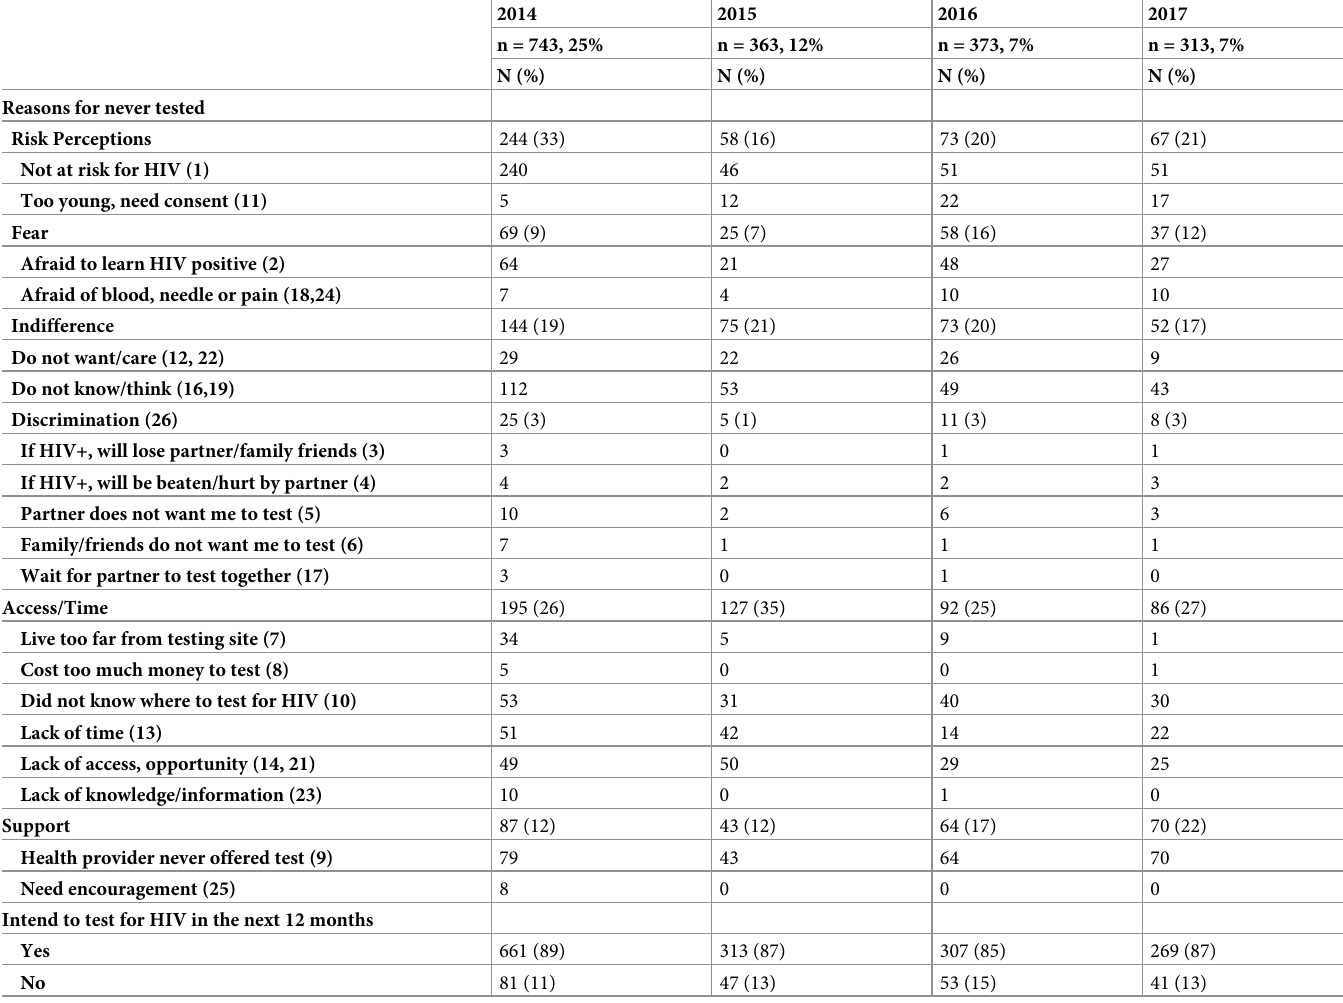
Table 3. Reasons for never tested for HIV before and intention to have HIV test in the next 12 month among never